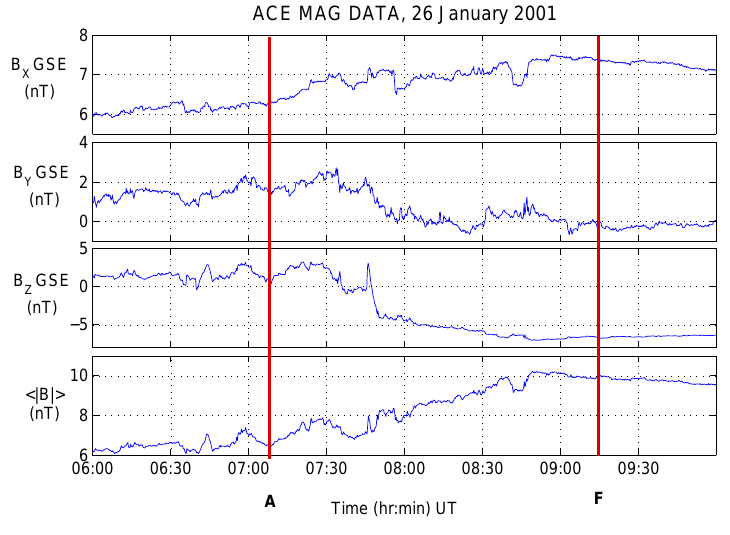
Fig. 3. The IMF conditions detected by the ACE spacecraft for 26 January 2001. Using a ∼ 74 min lag time calcu- lated from solar wind speed and ACE position, we have marked the region corresponding to the Cluster observa- tions shown in Fig. 4 with red vertical